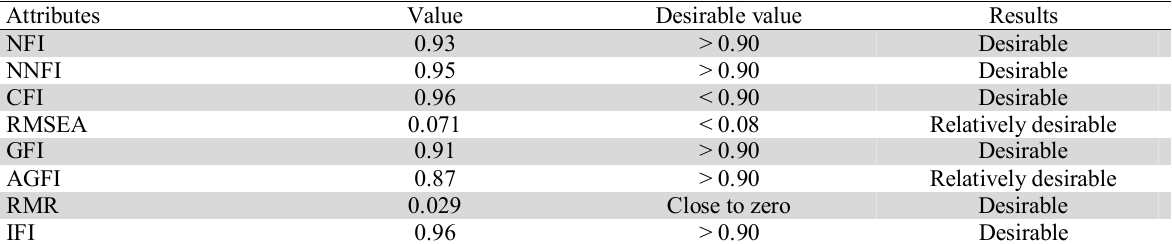
The summary of statistical observations associated with SEM implementation Attributes